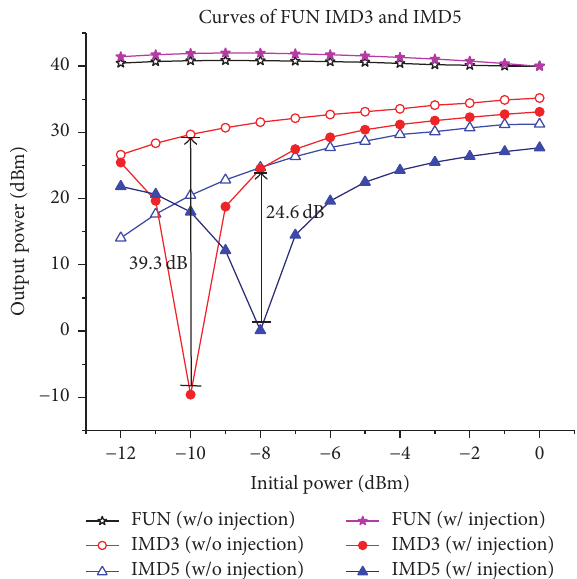
Figure 5: The output power of FUN, IMD3, and IMD5 according to initial power variation under optimum IM3 injection and without IM3